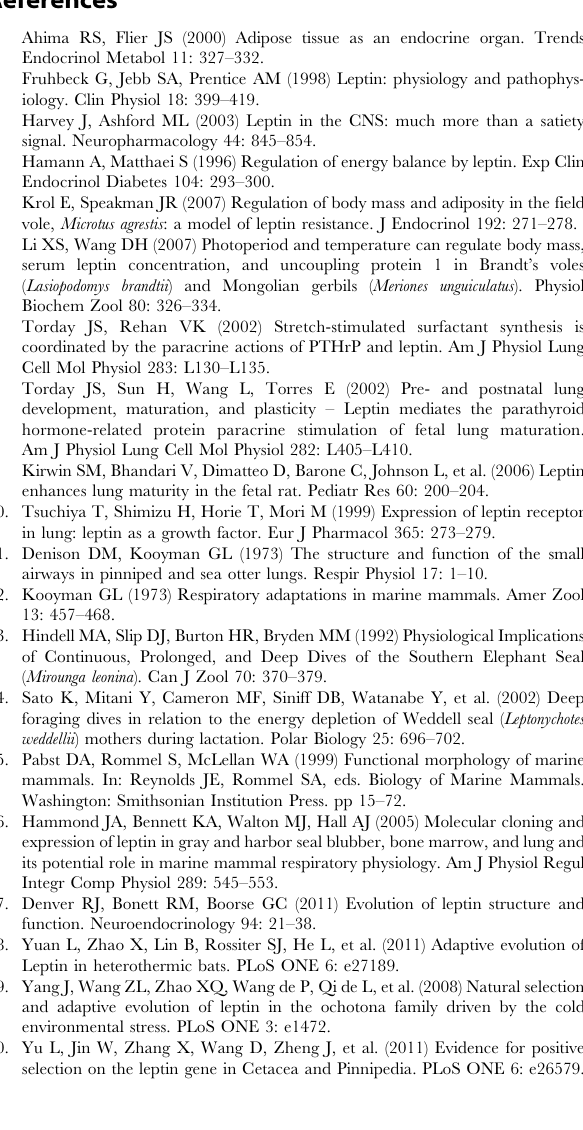
Figure S1 CLUSTAL X alignment of diverse mammali- an leptin nucleotide sequences which was manually edited using Bioedit version 7.0.5.3 [ 36 ] . Alignment used as a basis from which to compare phylogenetic topologies using MP, ML and NJ methods. A representative tree generated using NJ prediction is shown in manuscript Fig.